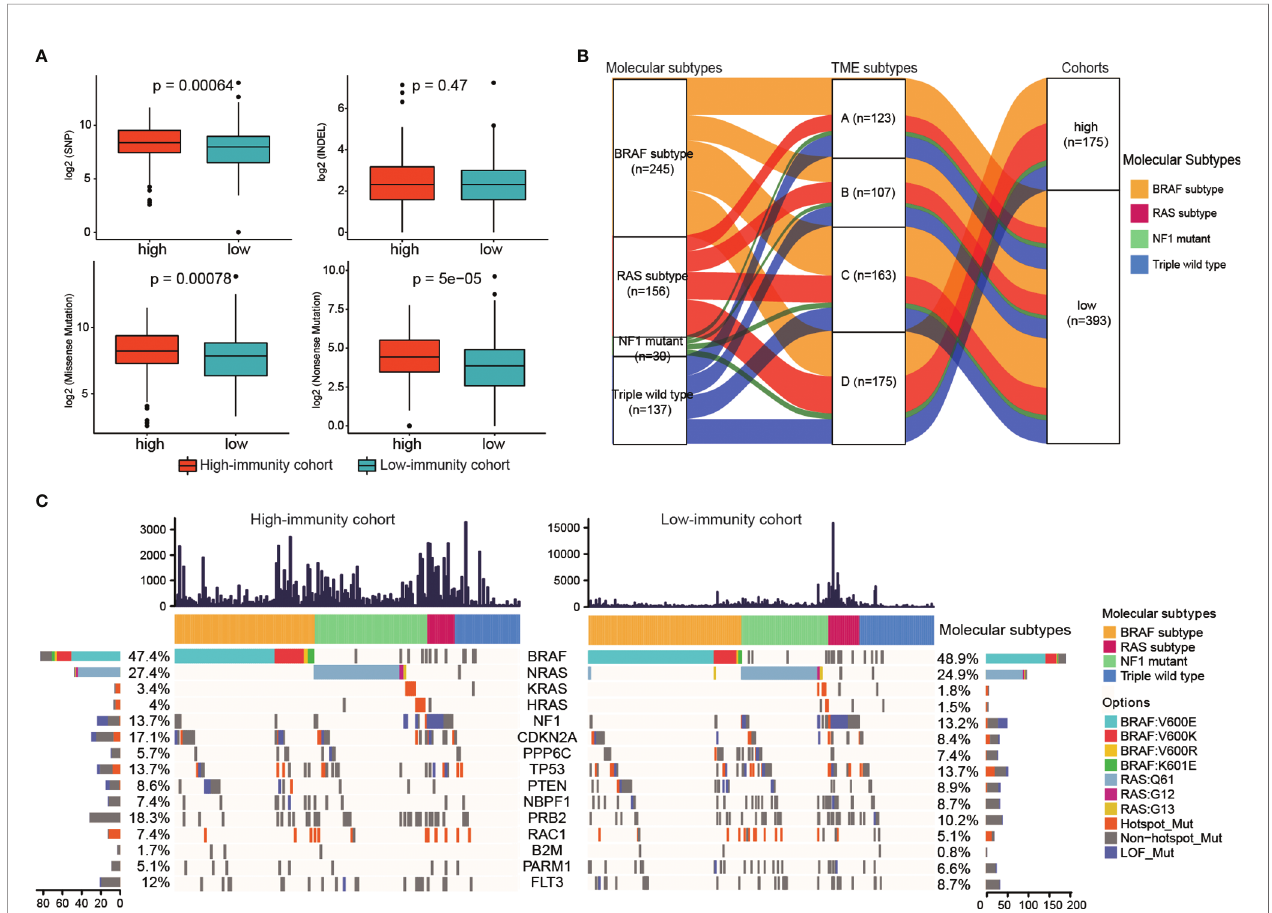
FIGURE 4 | The genomic characteristics under different immune subtypes. (A) The differences in the number of somatic mutations between the two immunity cohorts. (B) Alluvial diagram of molecular subtypes distribution under TME subtypes and two immunity cohorts. (C) Waterfall plot of the frequency distributions of the signi fi cantly mutated genes. The numbers of the mutations of each sample were showed in upper